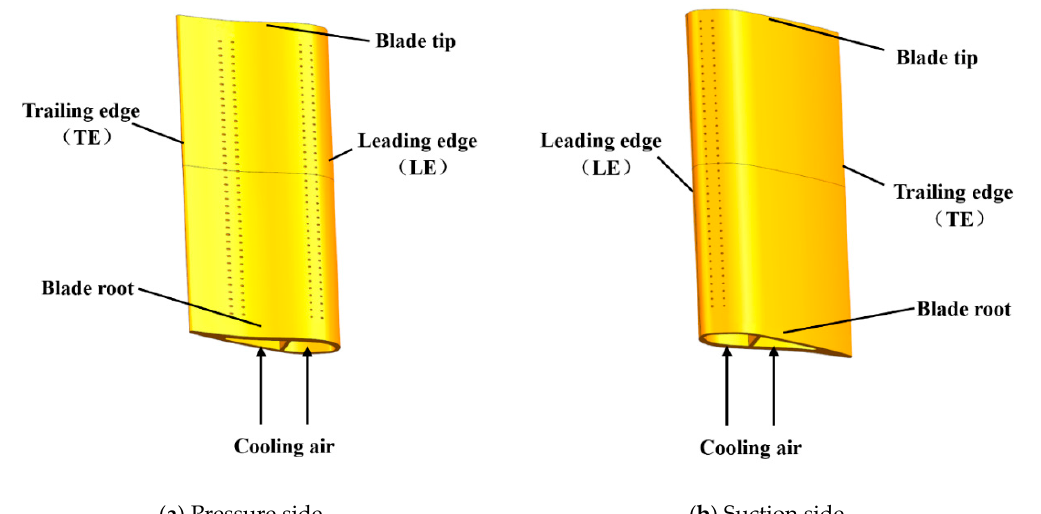
Figure 5. CAD drawing of the test model. Energies 2020 , 13 , x FOR PEER REVIEW